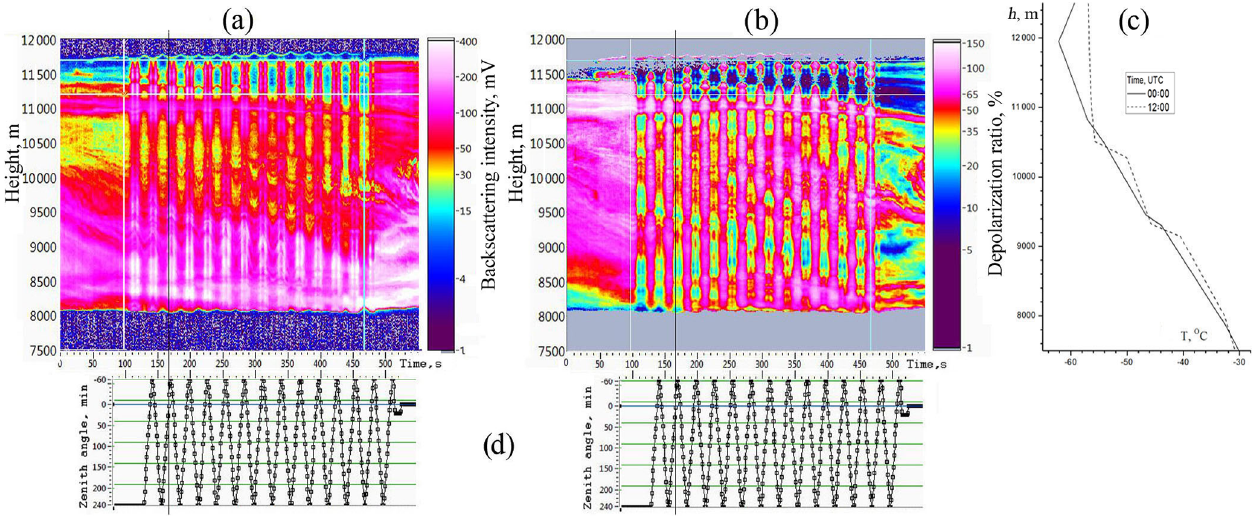
Figure 9. Lidar data on 2 June 2018 at 09:55LT. Designations as in Fig.